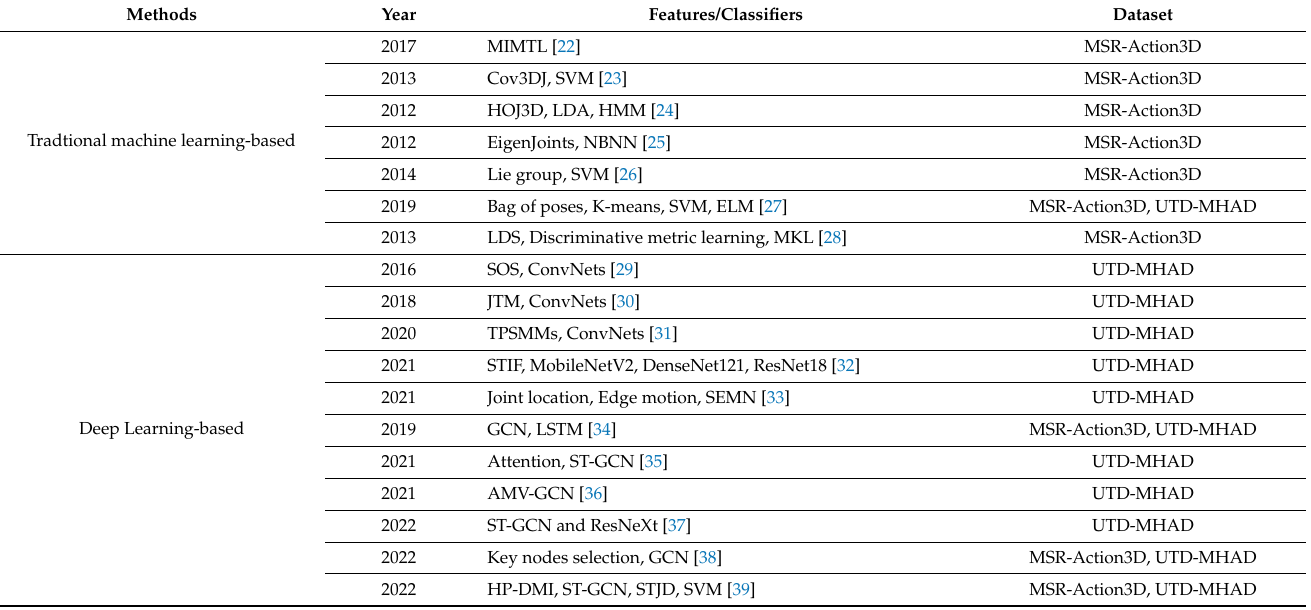
Table 1. State-of-the-art study descriptions.